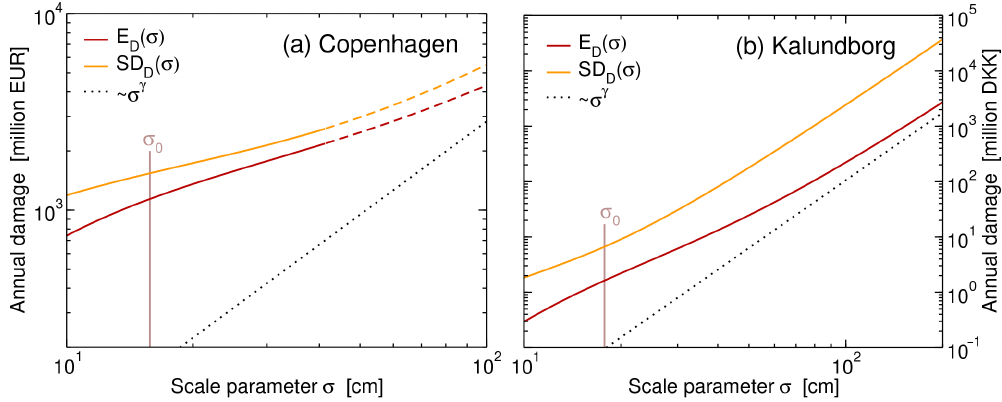
Figure A1. Expected annual damage (red) and standard deviations (orange) in (a) Copenhagen and (b) Kalundborg as a function of the scale parameter σ . The solid lines were numerically calculated with the available damage functions; the dashed continuations use an extrap- olation of the damage function as a power law with exponent γ = 1 . 6 (Copenhagen) and γ = 4 . 1 (Kalundborg). The dotted line shows the asymptotic results from Eqs. (B14) and (B15) and the current values of the scale parameter σ 0 = 15 . 79cm (Copenhagen) and σ 0 = 17 . 78cm (Kalundborg) are displayed as brown vertical